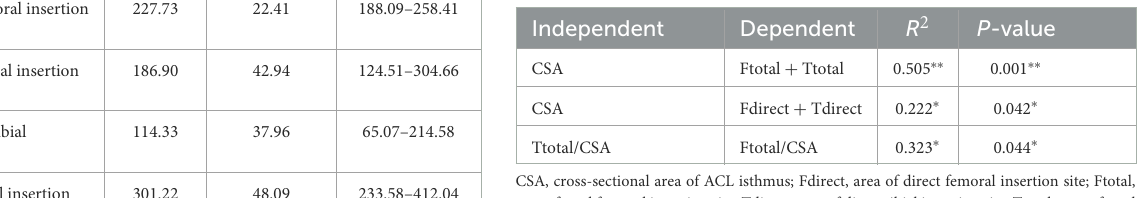
TABLE 4 Results of nonlinear regression analysis showing statistical significance (Sig.) and coefficient of determination ( R 2 ) between compound parameters of ACL morphology.